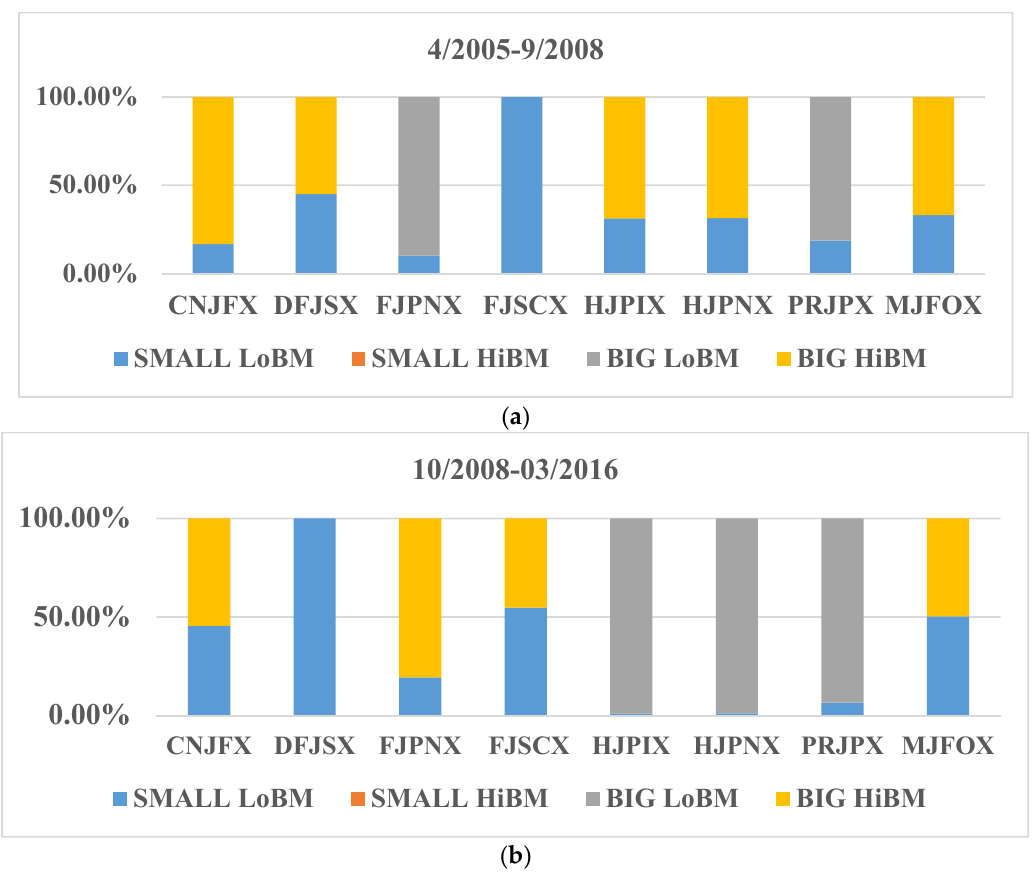
Figure 7 . Comparing investing styles before and after the crisis. (a) Investment styles before the Lehman Brothers Figure 7. Comparing investing styles before and after the crisis. ( a ) Investment styles before the default; (b) Investment styles after the Lehman Brothers default. Lehman Brothers default; ( b ) Investment styles after the Lehman Brothers